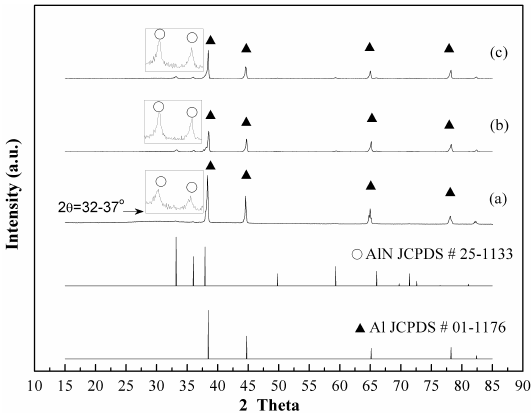
Figure 5. XRD patterns of prepared powders for plasma nitridation (in first stage) at 550 °C ( a ) 2 min, ( b ) 5 min, ( c ) 10 min (Al/NH 4 Cl = 1:1, applied power: 1200 W).